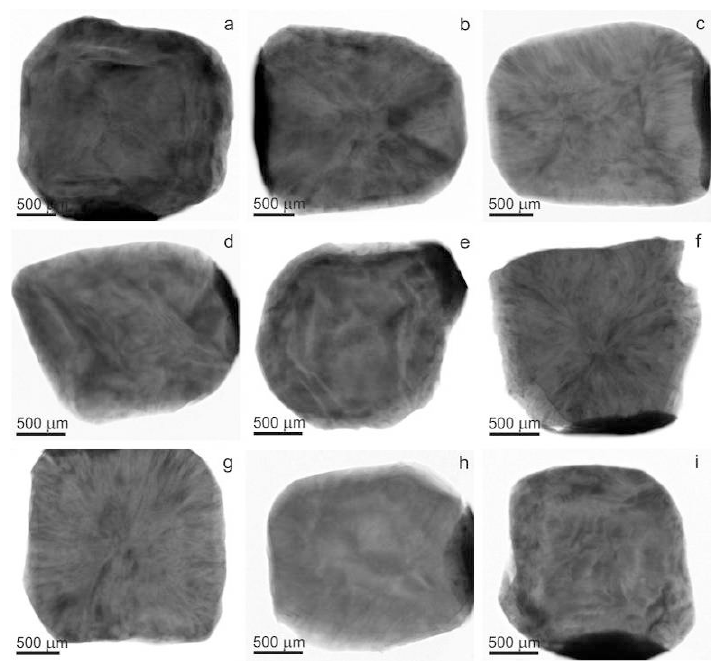
Figure 6. X-ray projection topographs of yellow cuboid diamonds from the Northeastern Siberian platform (the Burgers vector is directed horizontally to the left, (220) reflection) ( a —MP-30; b —MP-43; c —MP-56; d —MP-60; e —MP-71; f —MP-83; g —MP-87; h —MP-98; i —MP-108).